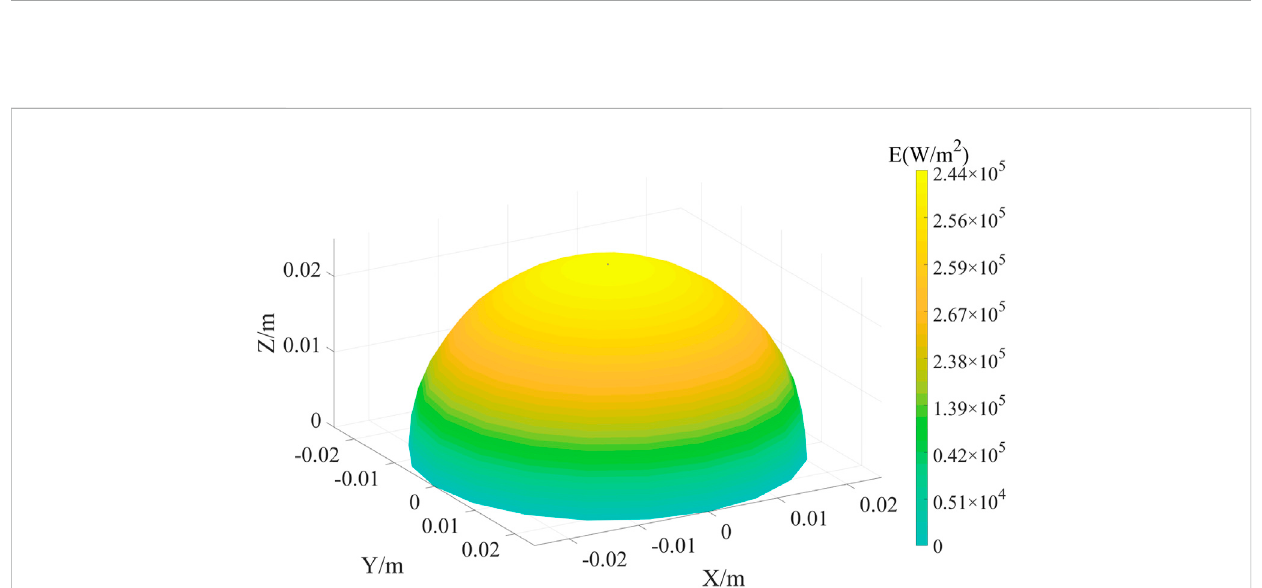
FIGURE 5 Flux density distribution of the hemisphere receiver with rotating parabolic concentrators (Liu et al., 2007).